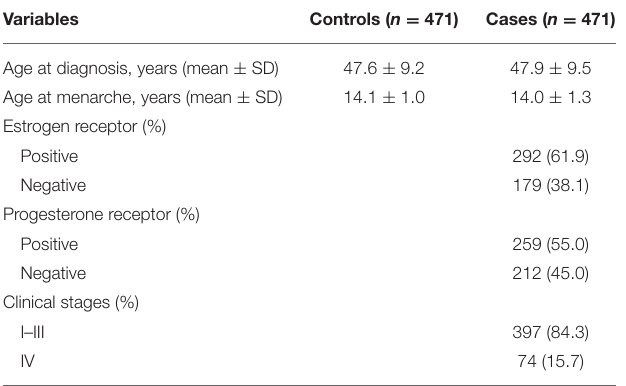
TABLE 1 | Clinical features of cases and controls. TABLE 2 | Association between SPP1 SNPs and the risk of